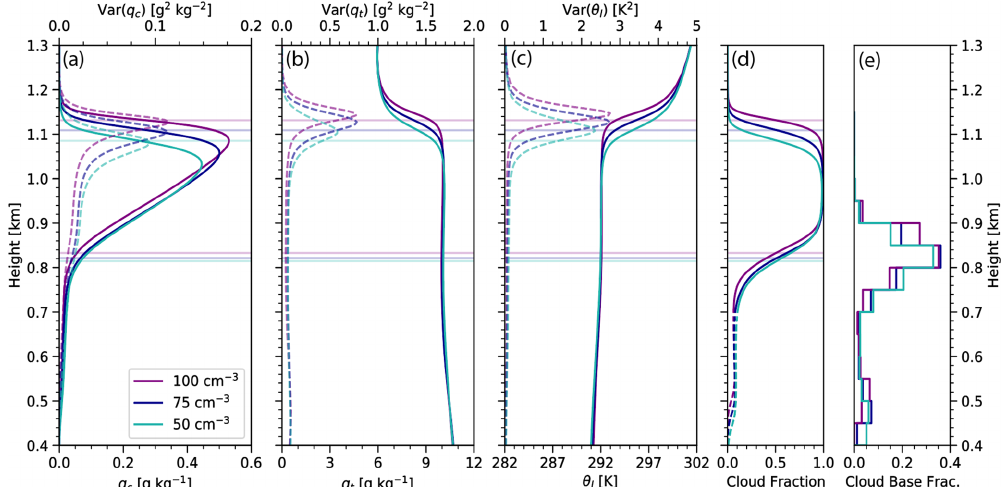
Figure 9. Vertical profile of the horizontal average (mean) and variance, averaged over the analysis period of 09:00–12:00UTC, of (a) the cloud liquid water mixing ratio q c , (b) the total water q t , (c) the liquid water potential temperature θ l , and (d) the cloud area fraction. The solid lines indicate mean quantities, and the dashed lines indicate variance. (e) Histogram of cloud-base height, with each value representing the area fraction of cloud bases lying within that 50m height interval. Purple, dark blue, and teal lines represent simulations with N c values with 100, 75, and 50cm − 3 , respectively. The colored lines correspond to cloud base and height as in Fig. 4.